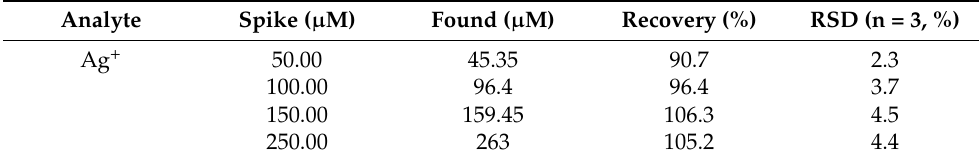
Table 1. Determination of Ag + in real samples.